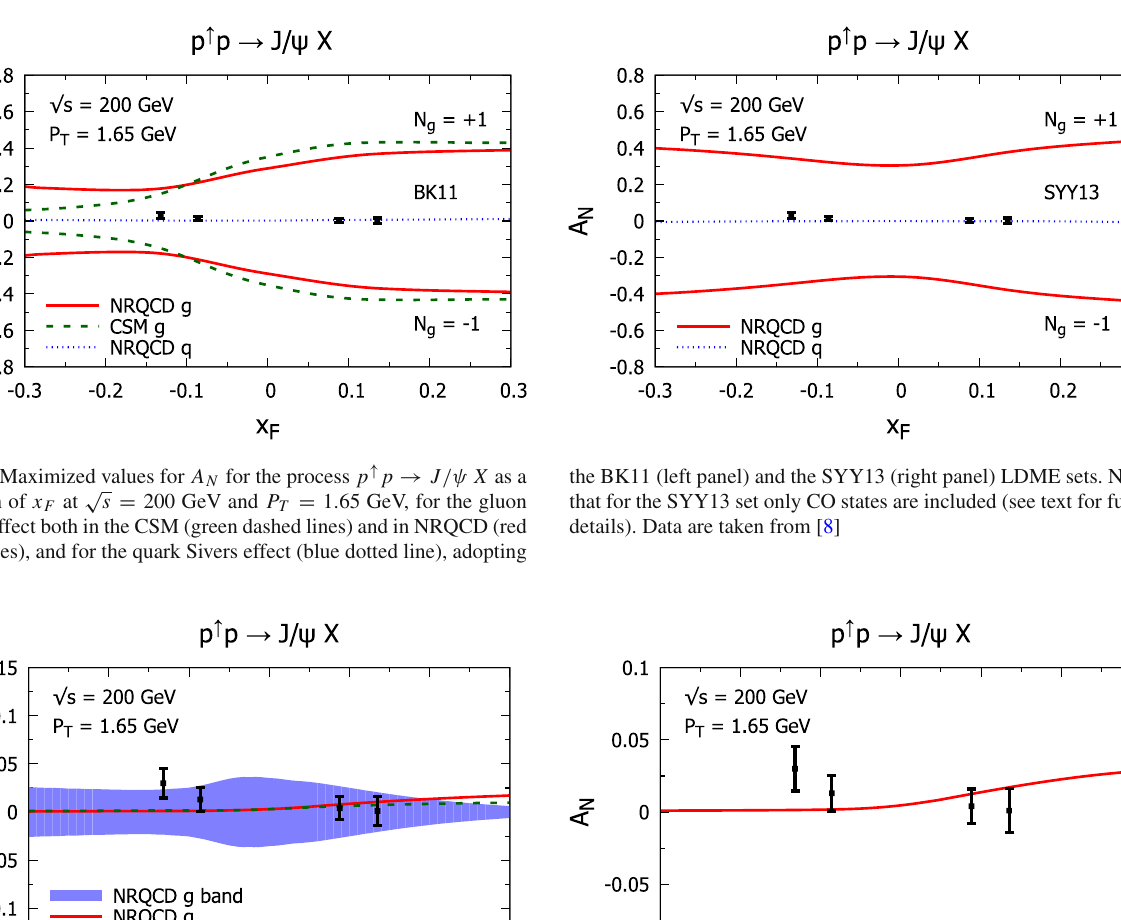
Fig. 4 Estimates of A N for the process p ↑ p → J /ψ X as a func- √ s = 200 GeV and P T = 1 . 65 GeV, both in the CSM tion of x F at (green dashed line) and the NRQCD approach (red solid line), adopting the BK11 (left panel) and the SYY13 LDME set (right panel), com-